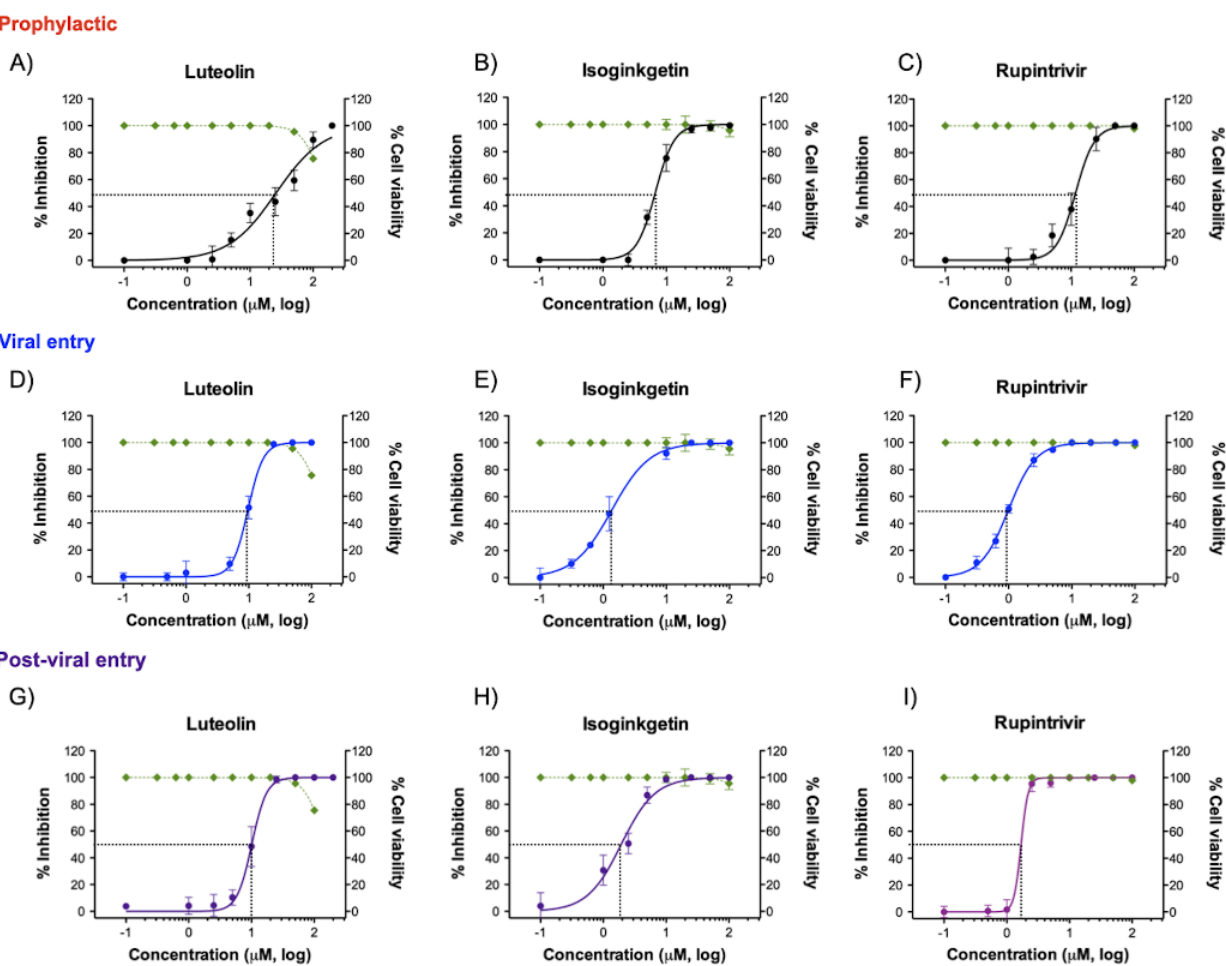
Figure 2. Dose–response curves between the effects of luteolin and isoginkgetin on FMDV inhibition and their cytotoxic effects on BHK-21 cells were established. Antiviral activities of the phytochemical compounds in the prophylaxis ( A – C ), viral entry ( D – F ), and post-viral entry ( G – I ) experiments were determined at different times of infections. The FMDV-infected cells were treated with different compound concentrations as depicted in Figure 1A and the numbers of FMDV-infected cells were determined by IPMA. The viability of the treated cells was also measured and compared to that of the cell control with 1% DMSO (non-inhibitor control) using the MTS assay (green line). Rupintrivir was used as a positive antiprotease drug control. All experiments were carried out in triplicates.